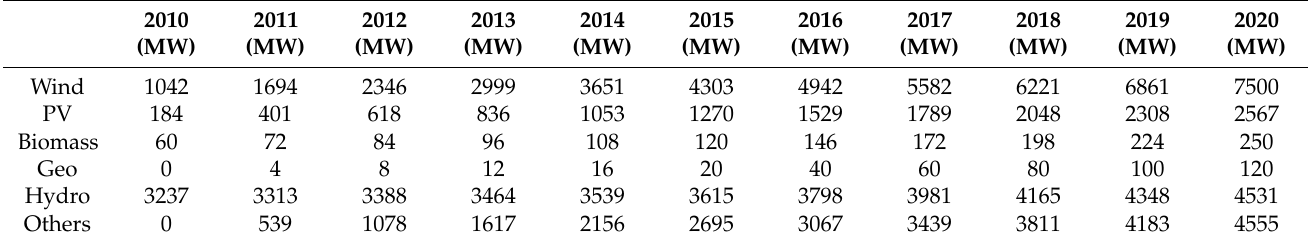
Table 7. Installed capacity in the future.